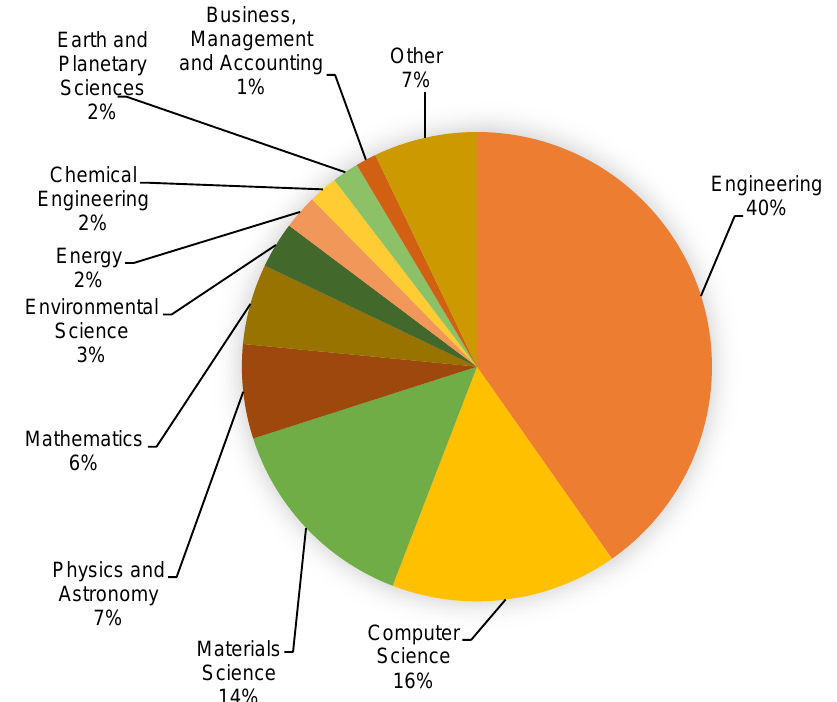
Figure 3. Relevant subject areas of documents.